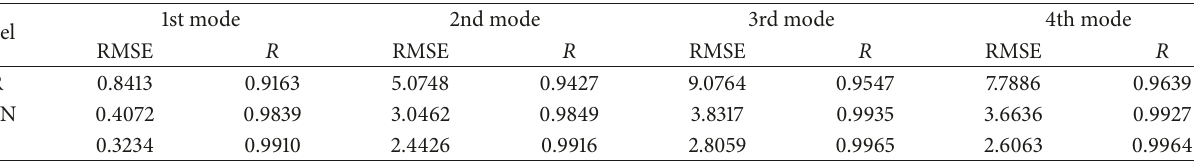
Table 2: RMSE and 𝑅 values of reproduced modal frequencies.